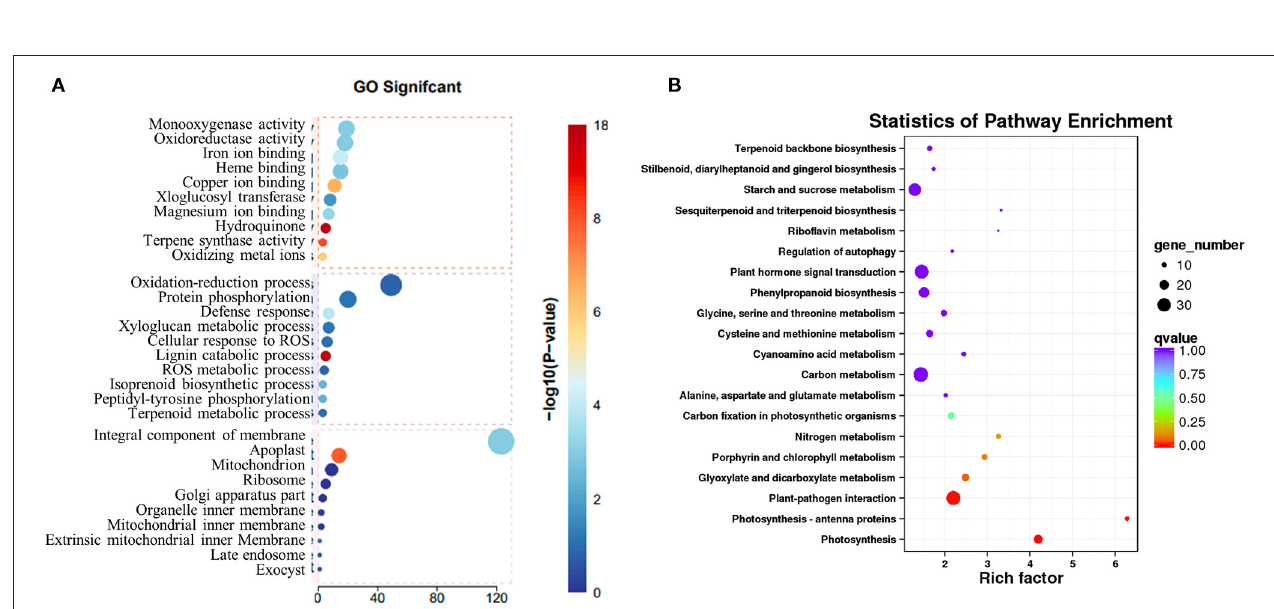
FIGURE 3 | Change of identified salvinolic acids (SalAs). Two-month-old S. miltiorrhiza was treated with CuSO 4 .5H 2 O (5 µ M) for 5 days. (A) The changes of identified SalAs in control and treated samples were analyzed using a Cluster analysis. (B) Pathway enrichment analysis of significantly changed metabolites was performed using the KEGG database.